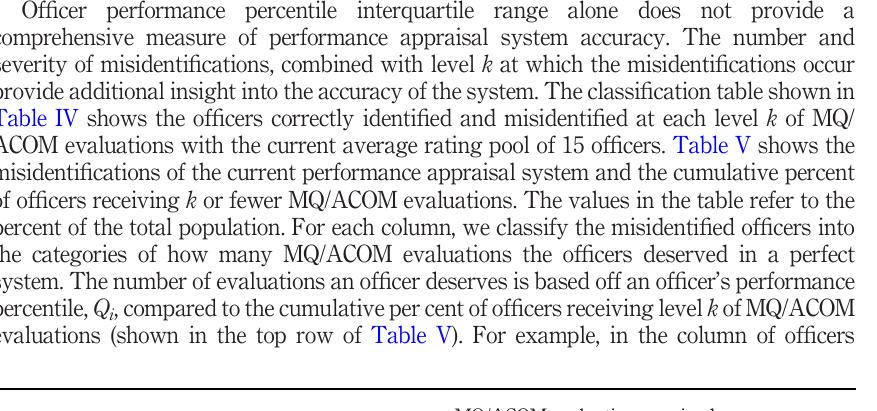
Table IV. Classi fi cation table